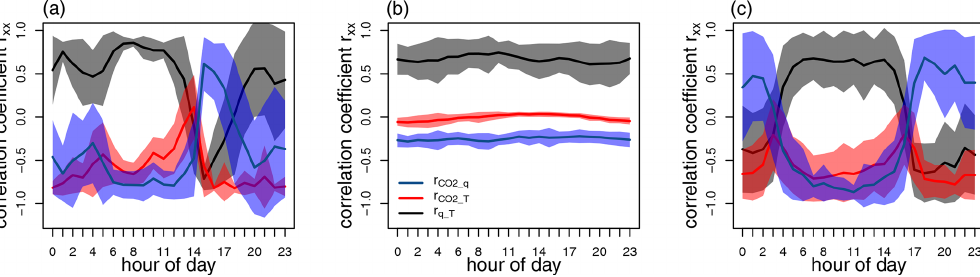
Figure 3. Diurnal course of scalar–scalar correlation coefficients r sp at the meadow site (a) , the loose-gravel-covered Dry Valleys site (b) , and the Waldstein forest site (c) ; ± 1 standard deviation σ is drawn as a semi-transparent area around the mean curves of r sp